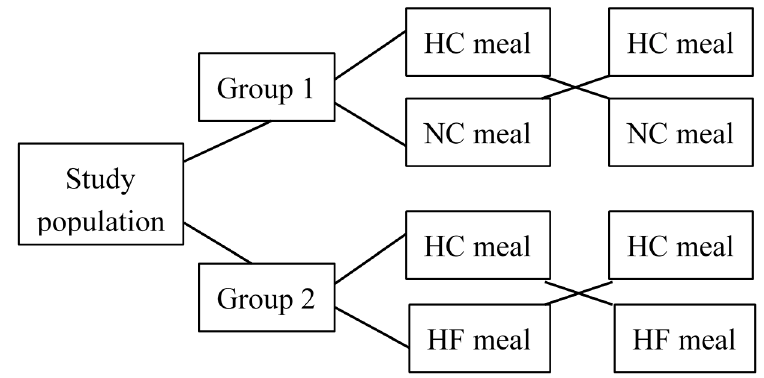
Figure 1. The study design. HC—high-carbohydrate meal; NC—normal-carbohydrate meal; HF—high-fat meal. Table 1. The study population characteristic. The results are presented as mean values ± SE. BMI—Body Mass Index.